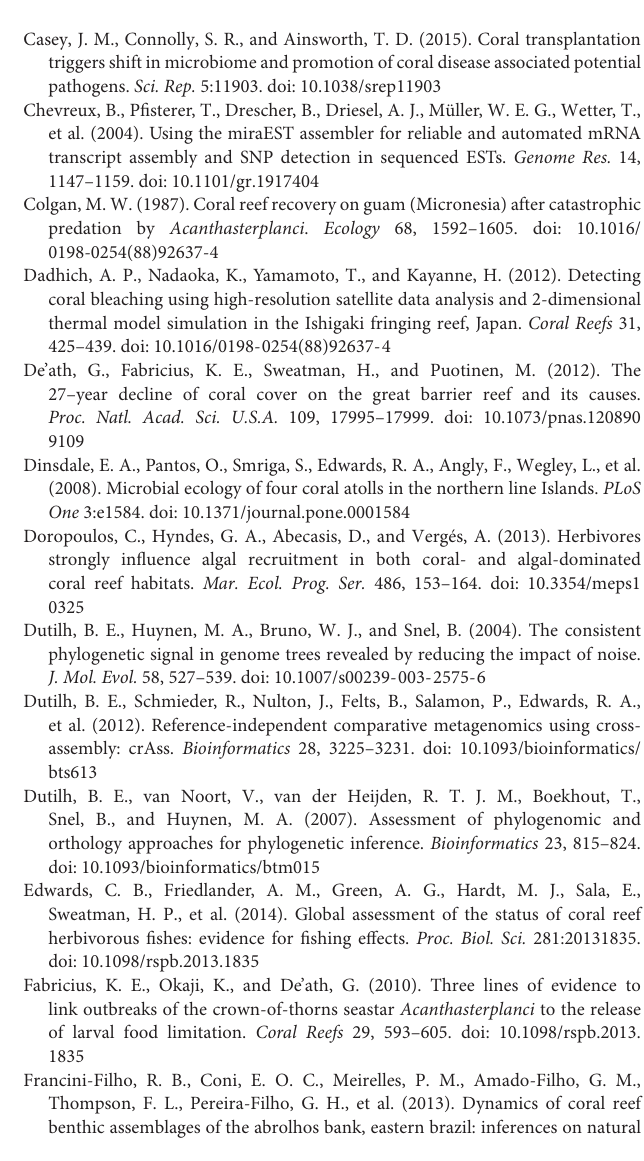
TABLE S2 | General features of the metagenomes. TABLE S3 | Metagenomes taxonomic annotation at Domain level and bacterial family diversity. TABLE S4 | Adonis (Permanova) results of benthic cover based on Bray-Curtis distances with 999 permutations. MS, mean sum of squares; SS, sum of squares. TABLE S5 | ANOVA results of total fish abundance. DF, degrees of freedom; SS, sum of squares; MS, mean sum of squares. TABLE S6 | Adonis (Permanova) results of fish community abundance based on Bray-Curtis distances with 999 permutations. DF, degrees of freedom; SS, sum of squares; MS, mean sum of squares. TABLE S7 | ANOVA results of total bacterial abundance. DF, degrees of freedom; SS, sum of squares; MS, mean sum of squares. TABLE S8 | ANOVA results of Vibrio counts. DF, degrees of freedom; SS, sum of squares; MS, mean sum of squares.